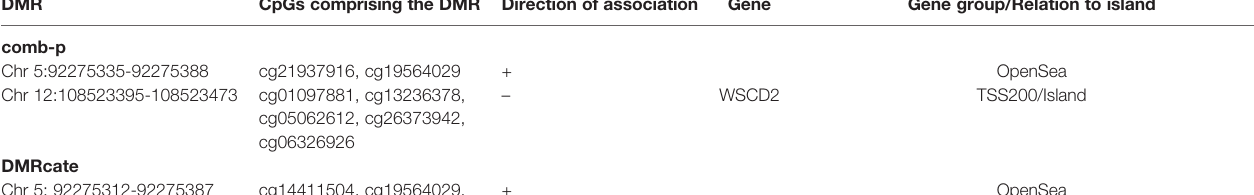
TABLE 4 | Differentially methylated regions (DMRs, GDM vs. control groups) identi fi ed by both comb-p and DMRcate package in region-level data analyses in R.